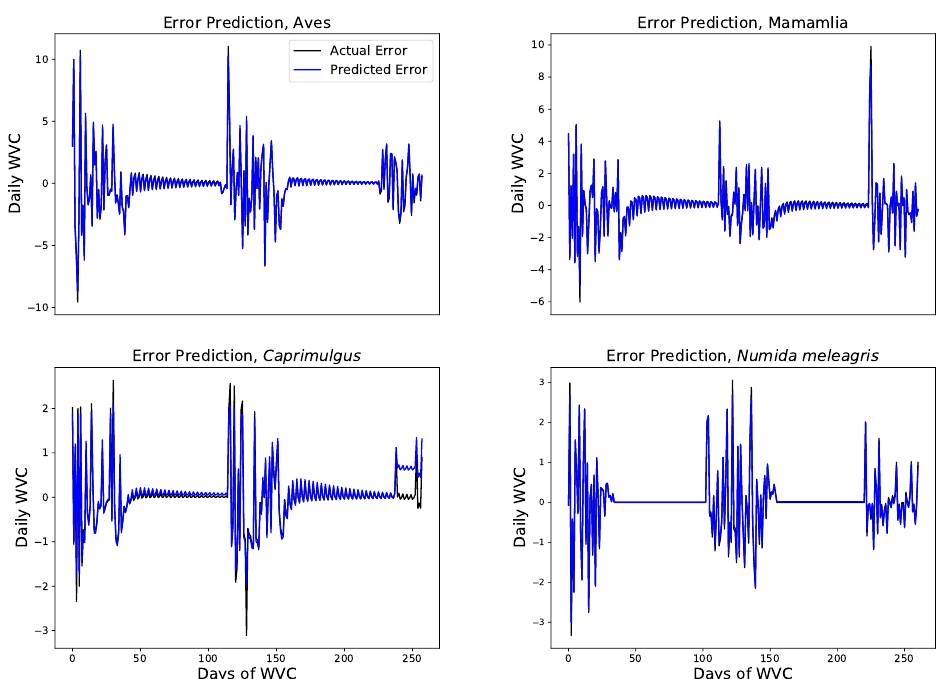
Figure 11. Daily actual residuals and predicted residuals of Aves taxa from the SARIMAX-only model.